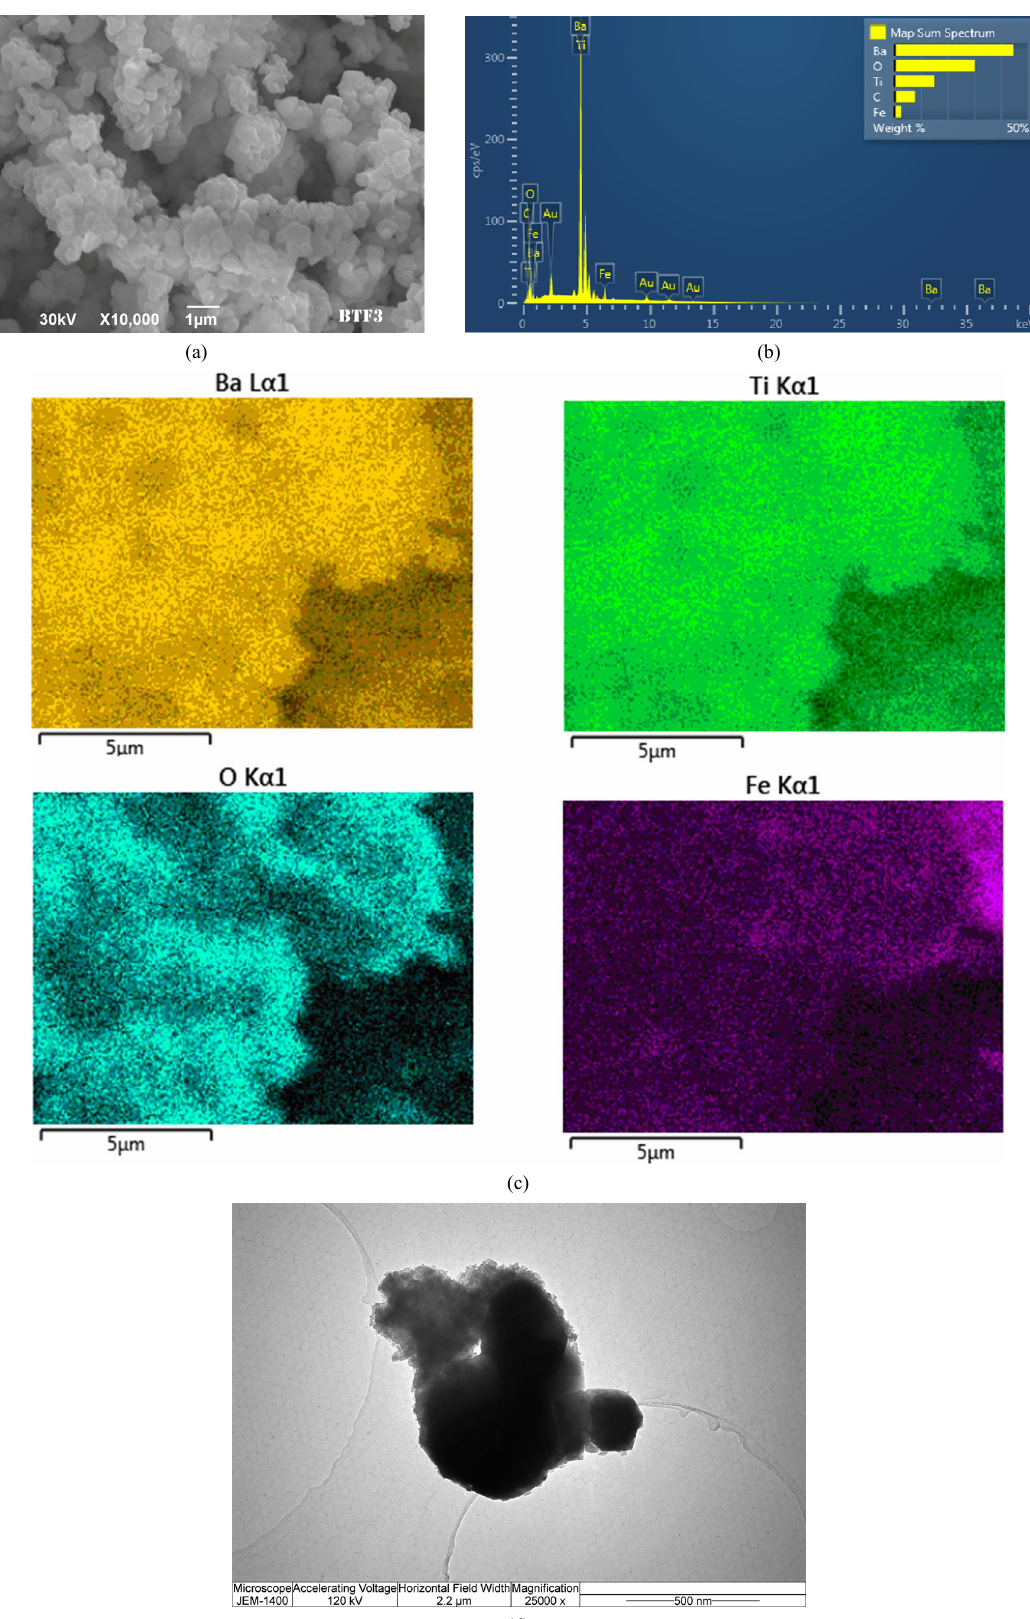
Fig. 6 (a) SEM; (b) EDS; (c) mapping of elements; (d) TEM for the sample